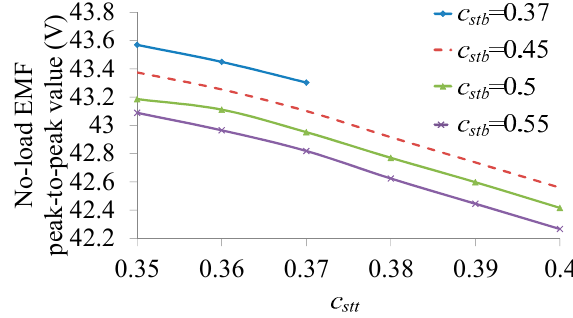
Figure 11. No-load EMF peak-to-peak value with different c stt and c stb .